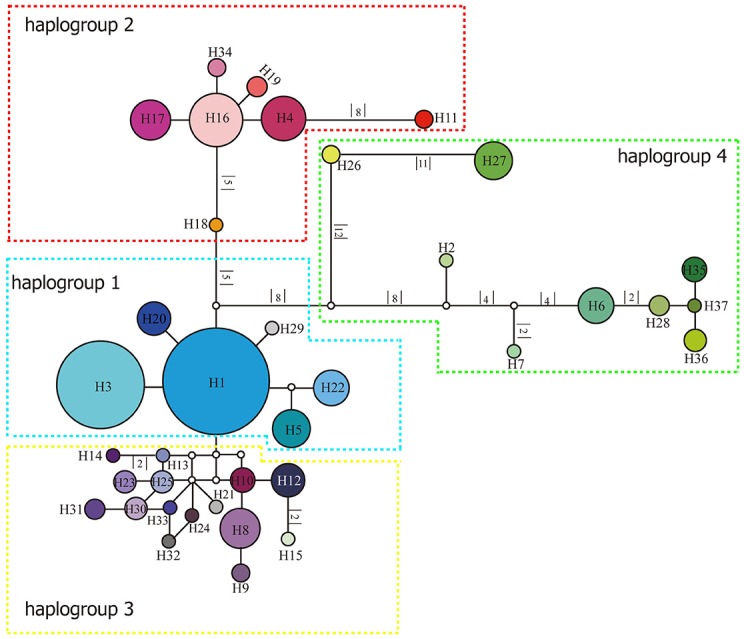
Network of relationships among the 37 cpDNA haplotypes found in Parasyncalathium souliei. Missing haplotypes are represented by white circles. The sizes of circles are approximately proportional to sample size. Branch lengths are indicated by the numbers along branches.